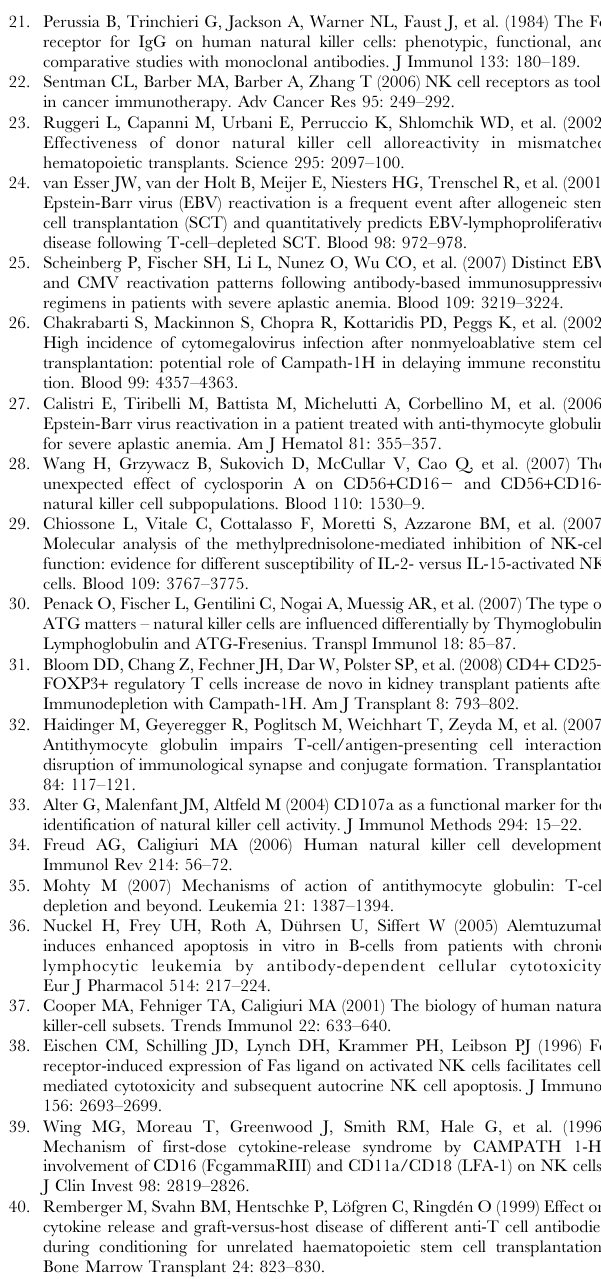
Found at: doi:10.1371/journal.pone.0004709.s001 (0.03 MB Figure S1 Found at: doi:10.1371/journal.pone.0004709.s002 (0.18 MB Figure